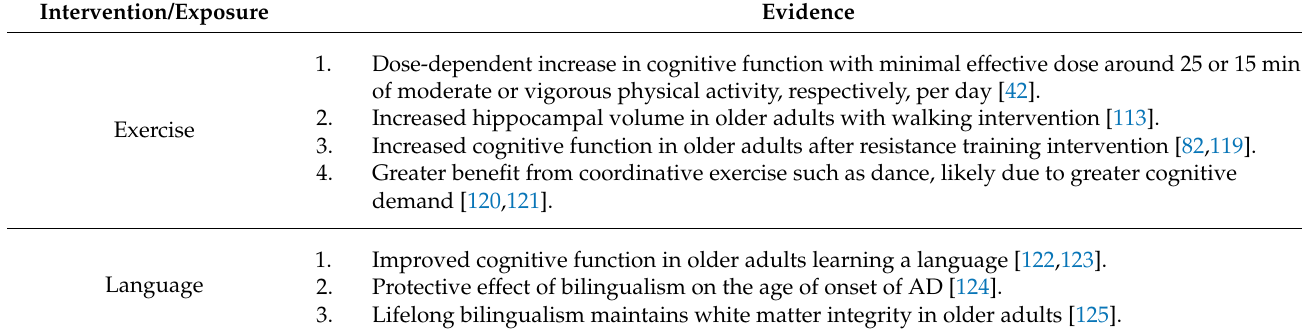
Table 2. Potential interventions. Environmental and lifestyle exposures and stimuli associated with reduced risk of age-related dementia, all of which are likely to provide a significant proportion of their benefit through cognitive